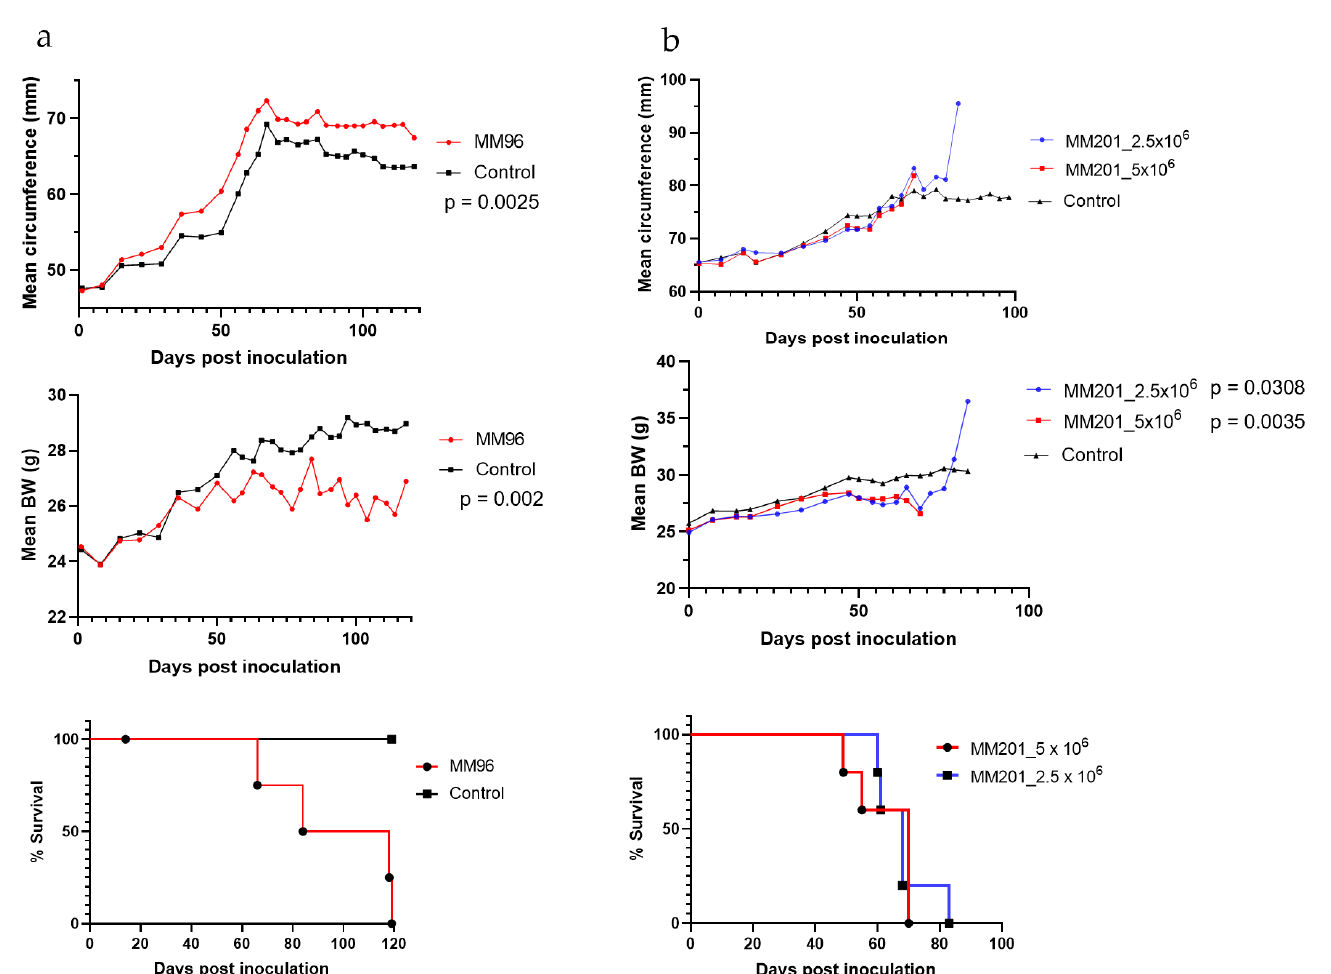
Figure 1. Mean circumference (top panel), mean body weight (middle panel) and Kaplan–Meier curve (bottom panel) in animals inoculated i.p. with ( a ) MM96 or ( b ) MM201 cells. Animals inoculated with SFM were used as control. One of the animals in MM96-injected group was found dead at 14 dpi due to injection related injury.